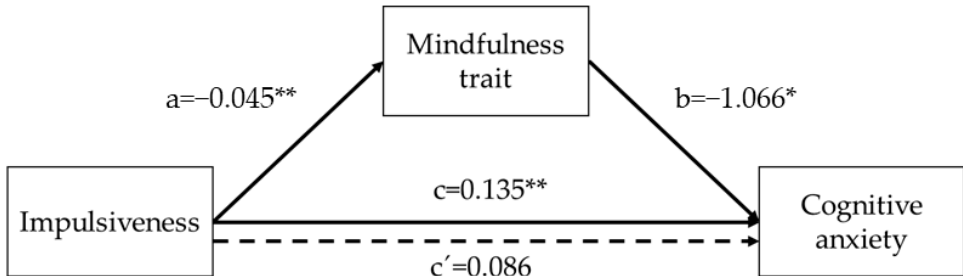
Figure 1. Graphical representation of the mediation effect of mindfulness in the association between impulsiveness and cognitive anxiety. The numerical values correspond to the unstandardized regression coefficients. Dashed line represents the mediated association. ** p < 0.01; * p < 0.05.